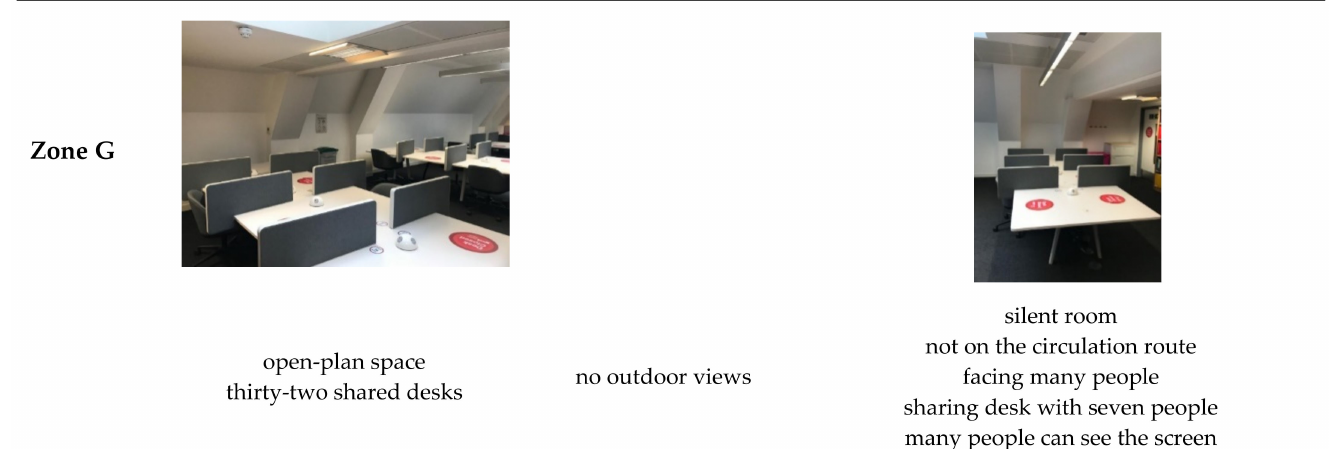
Figure 3. Defined zones in the Bartlett library.